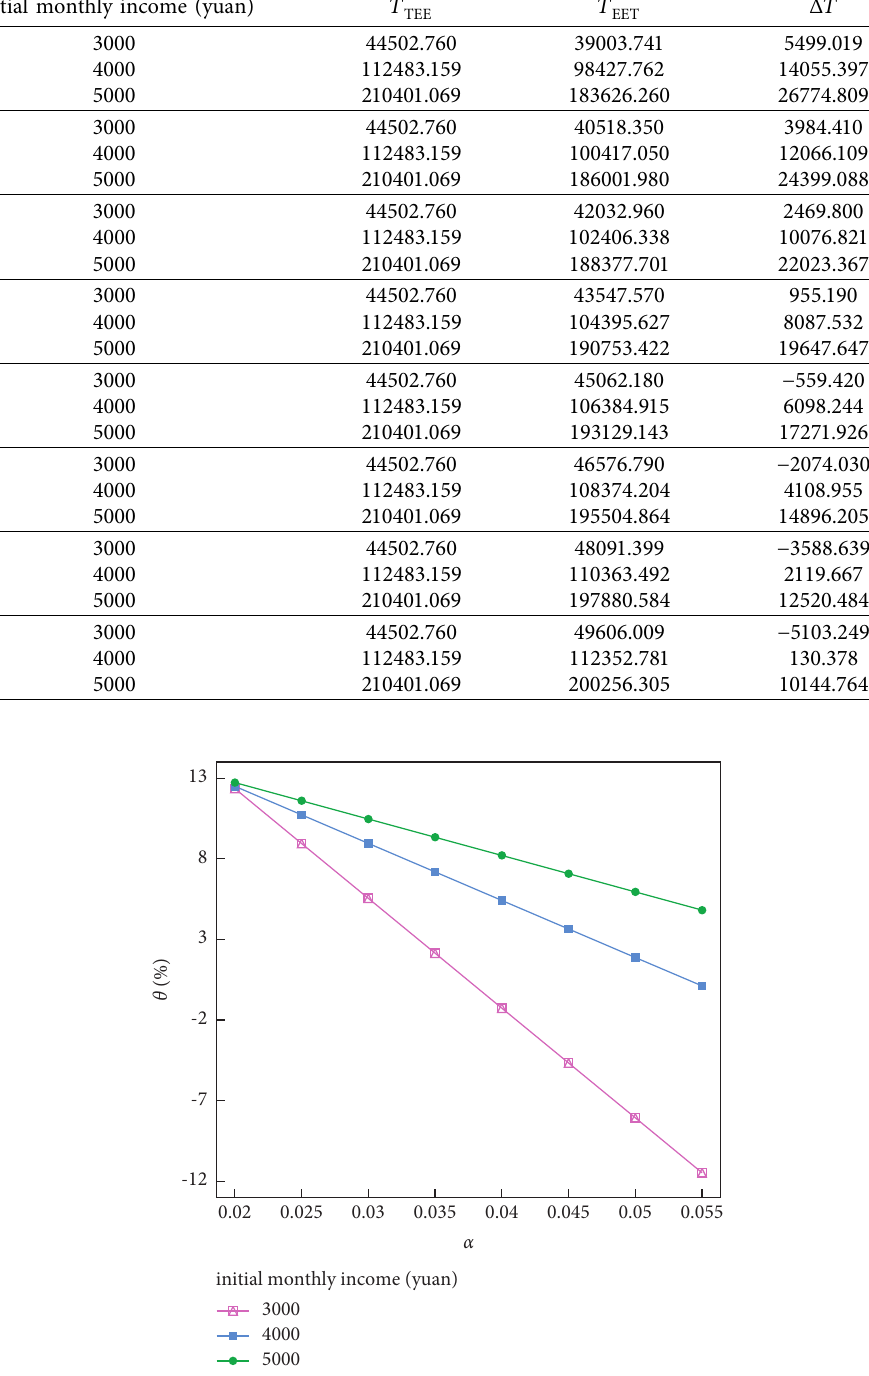
Figure 2: Tax-saving rate under the tax rate of different insurance